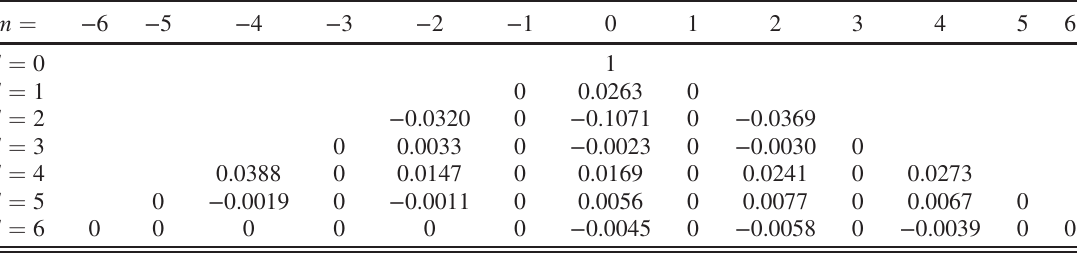
TABLE II. Normalized coefficients a ðþ Table